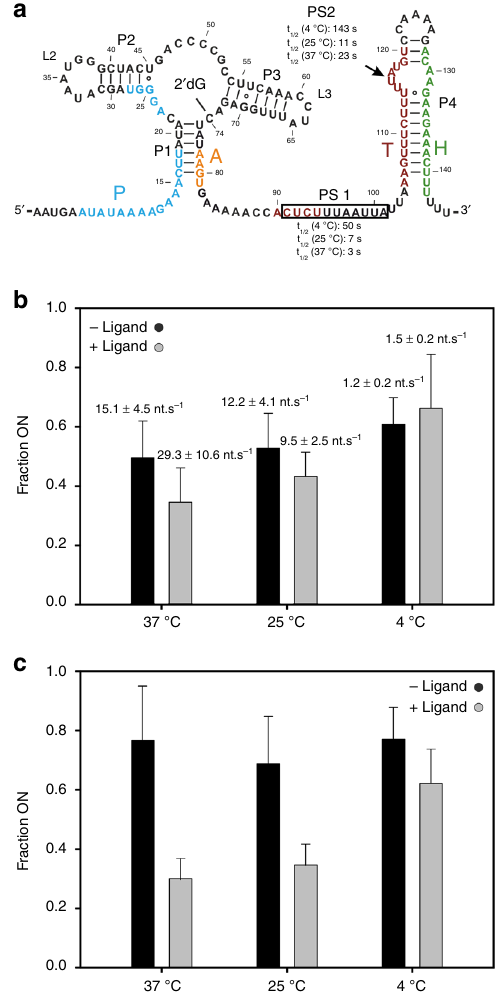
Fig. 6 Fractions of ON state derived by in vitro transcriptions. a Secondary structure of dGsw illustrating determined pause sites including t 1/2 values using E . coli polymerase (Supplementary Fig. 6 and Table 4 b, c ) fractions of ON state from E. coli RNAP mediated b single-round and c multi-round in vitro transcriptions performed in the absence (black) and presence of ligand (gray) at 37 °C, 25 °C, and 4 °C with an NTP concentration of 0.05 mM ( b ) and 0.1 mM ( c ) (Supplementary Fig. 5, 6). Indicated transcription rates are correlated to the time point, at which half of the polymerases have transcribed the corresponding mRNA fragment